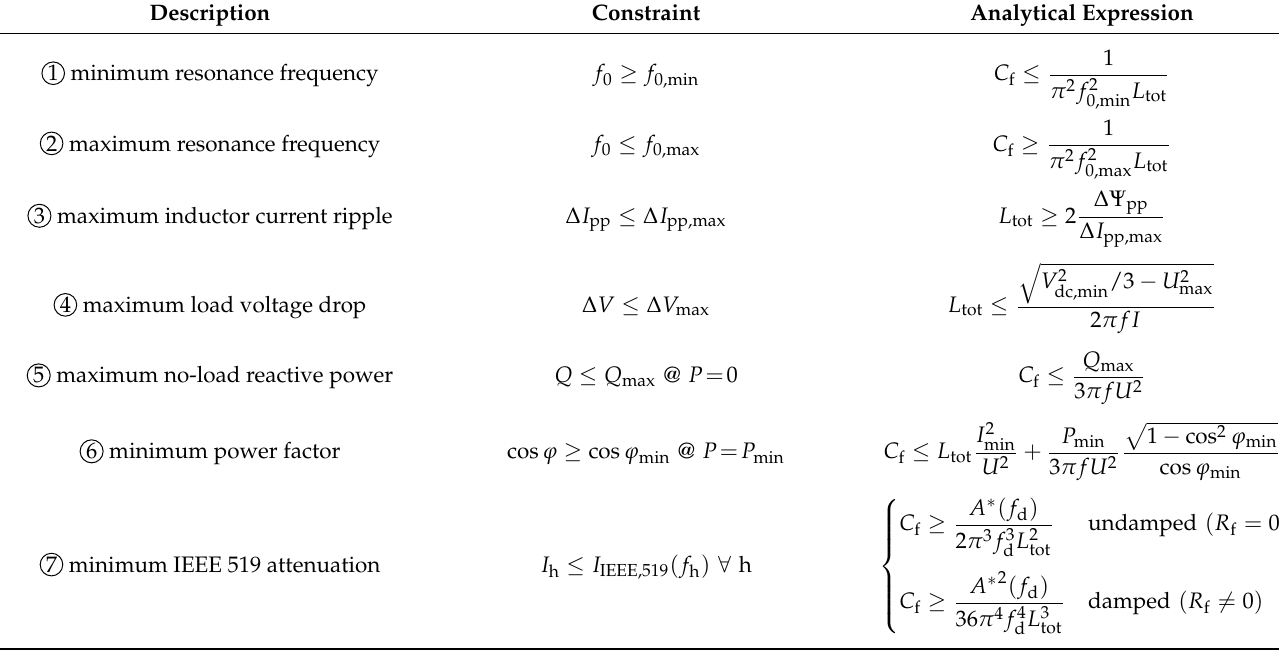
Table 3. LCL filter design constraints in terms of C f and L tot , considering L g = 0, L = L f (i.e., k L = 1) and R f = 1/ ( 3 ω 0 C f ) .